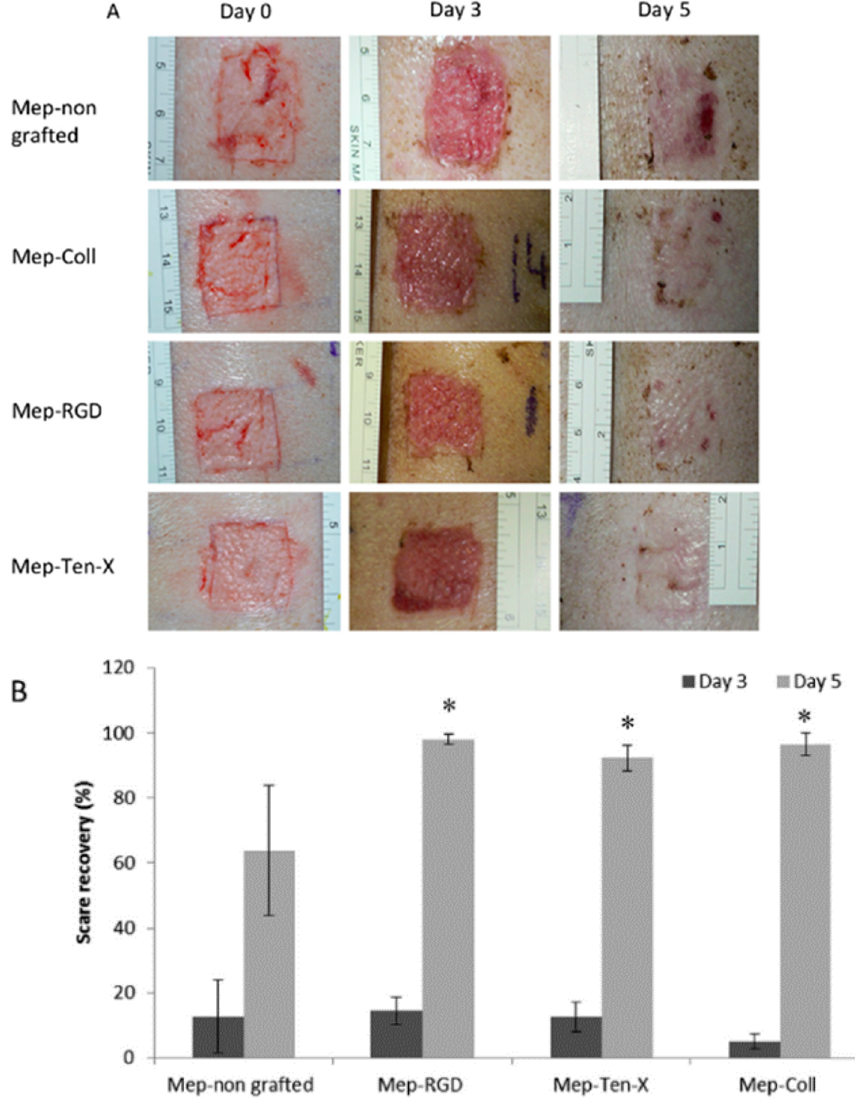
Figure 17. In vivo study. ( A ) Pictures of wounds inflicted on the back of a pig (at days 0, 3 and 5); ( B ) percentage of recovery of the scars (peptide-treated vs. non-treated dressings). Reproduced from [83]. Copyright © 2017 Elsevier Ltd. All rights reserved. Statistically significant differences vs. control samples are indicated with an * ( p <